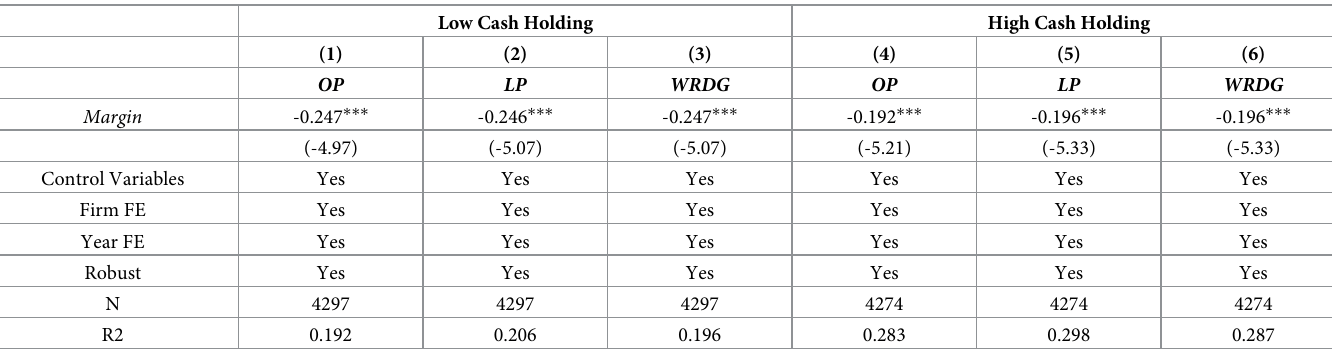
Table 8. Cross-sectional analysis by cash holding ratio.